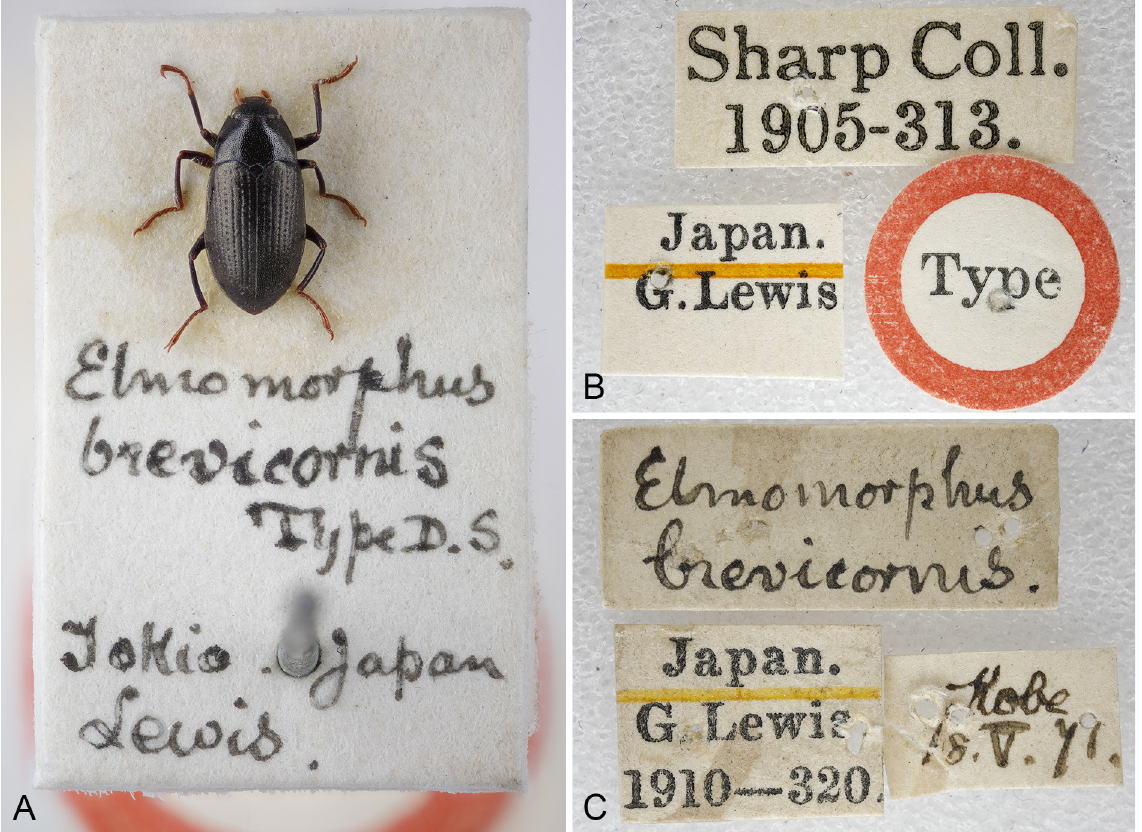
Fig. 4. Elmomorphus brevicornis Sharp, 1888. A–B . Syntype, ♀ (NHMUK). A . Specimen glued on the original card with Sharp’s handwriting. B . Labels. C . Syntype, ♂ (NHMUK), labels (the last label not